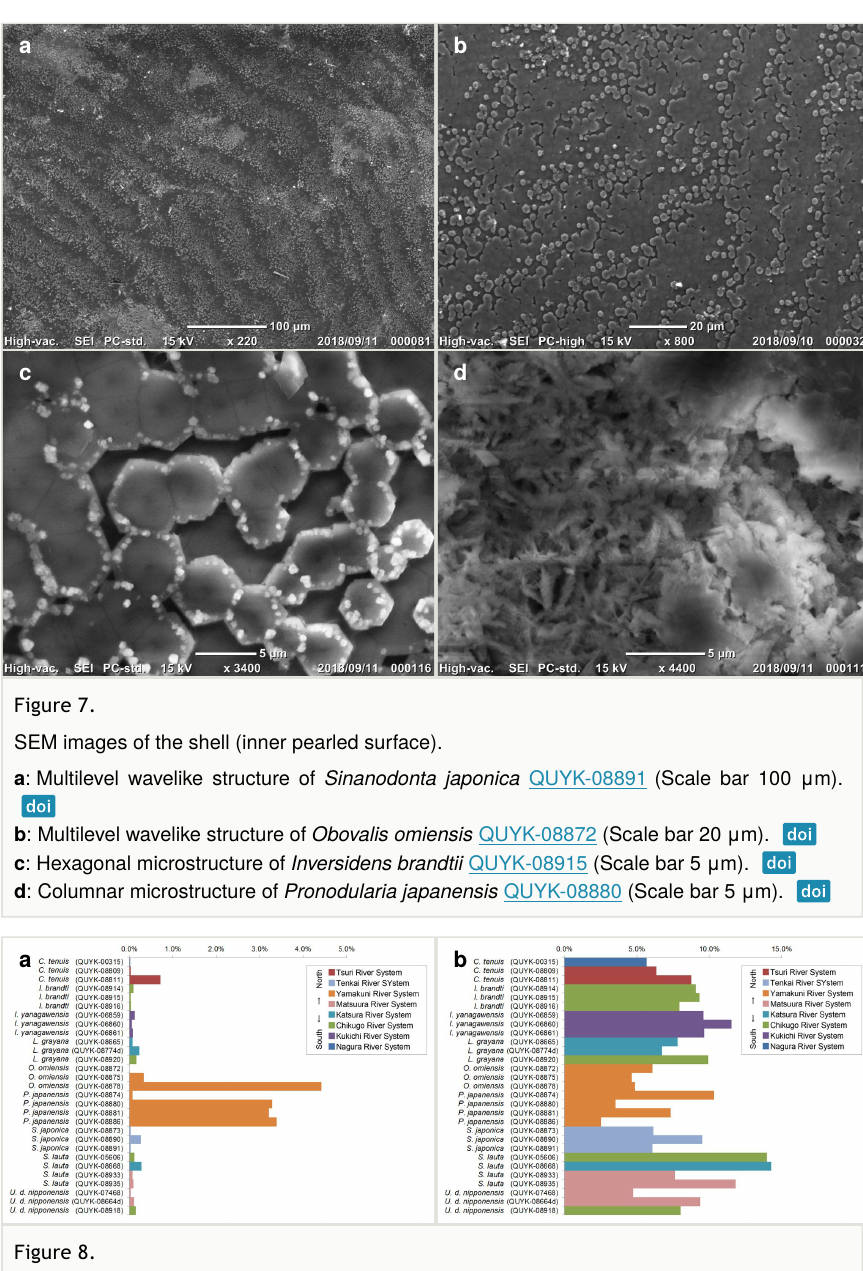
Figure 8. Elemental compositions of the shell (% number of atoms) discriminated by locality. a : Phosphorous. b :